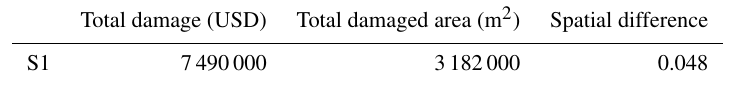
Table 4. Calculated total damage, total damaged area and spatial difference for S1.